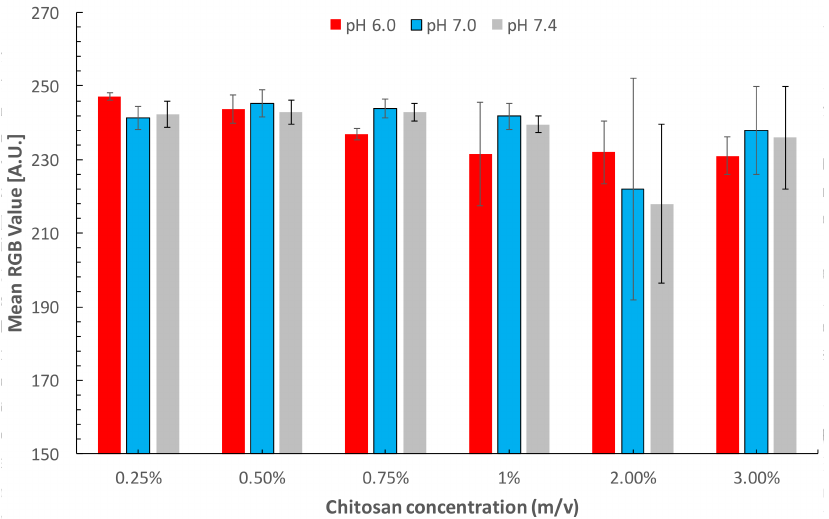
Figure 3. Effect of chitosan concentration and pH over the mean pixel value of a model